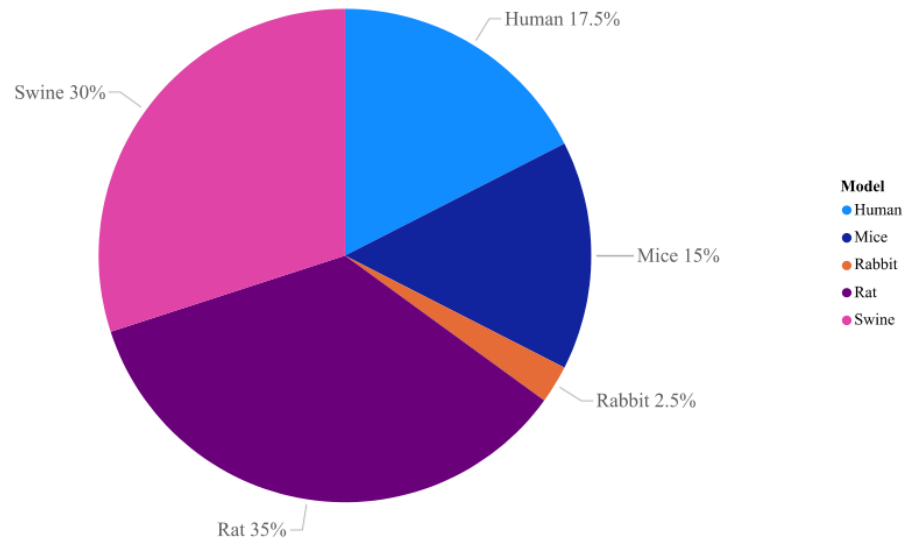
Figure 2. Models found in the PubMed database for pancreas decellularization between 2009 and 2021. The rat is the most used animal so far, representing 35% of the studies, followed by the swine model (30%), humans present about 17.5% of the data described in the literature, soon after it can be highlighted the mice (15%), while the least used species so far are rabbits (2.5%).